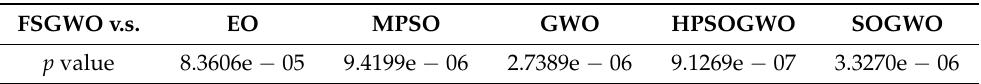
Table 3. Results of the Wilcoxon test for the mean values in Table